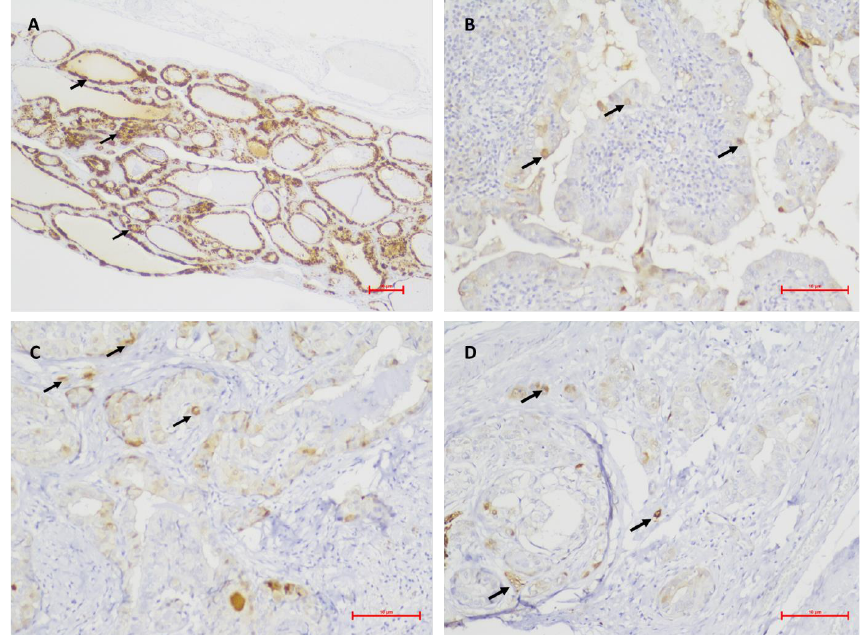
Figure 3. Photomicrographs of the immunohistochemical staining of MT (arrows) in the different studied groups, being able to differentiate benign neoplasm from all PTC groups but not between PTC groups. ( A ), Benign neoplasm, score 3 (original magnification × 100); ( B ), PTC + 0, score 1 (original magnification × 200); ( C ), PTC + E, score 1 (original magnification × 200); ( D ), PTC + M, score 1 (original magnification × 200).